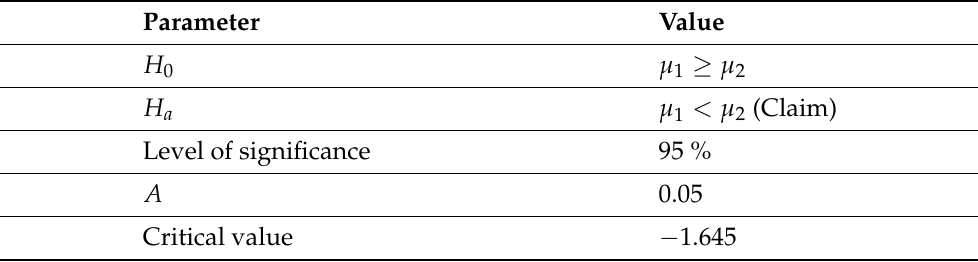
Table 9. Statistical z -test